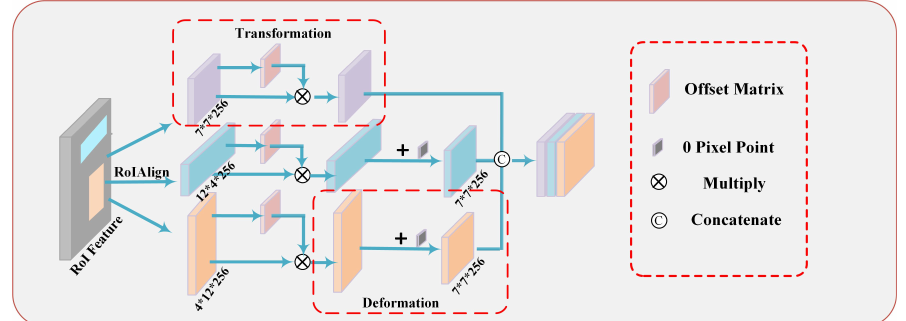
Figure 6. Illustration of process of DRoI module. DRoI module uses three transformation operations and two deformation operations. Transformation operation and deformation operation are circled with red frames.